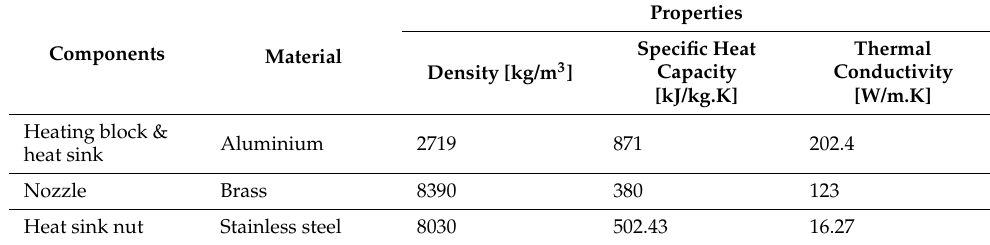
Table 3. Material properties for extruder components.